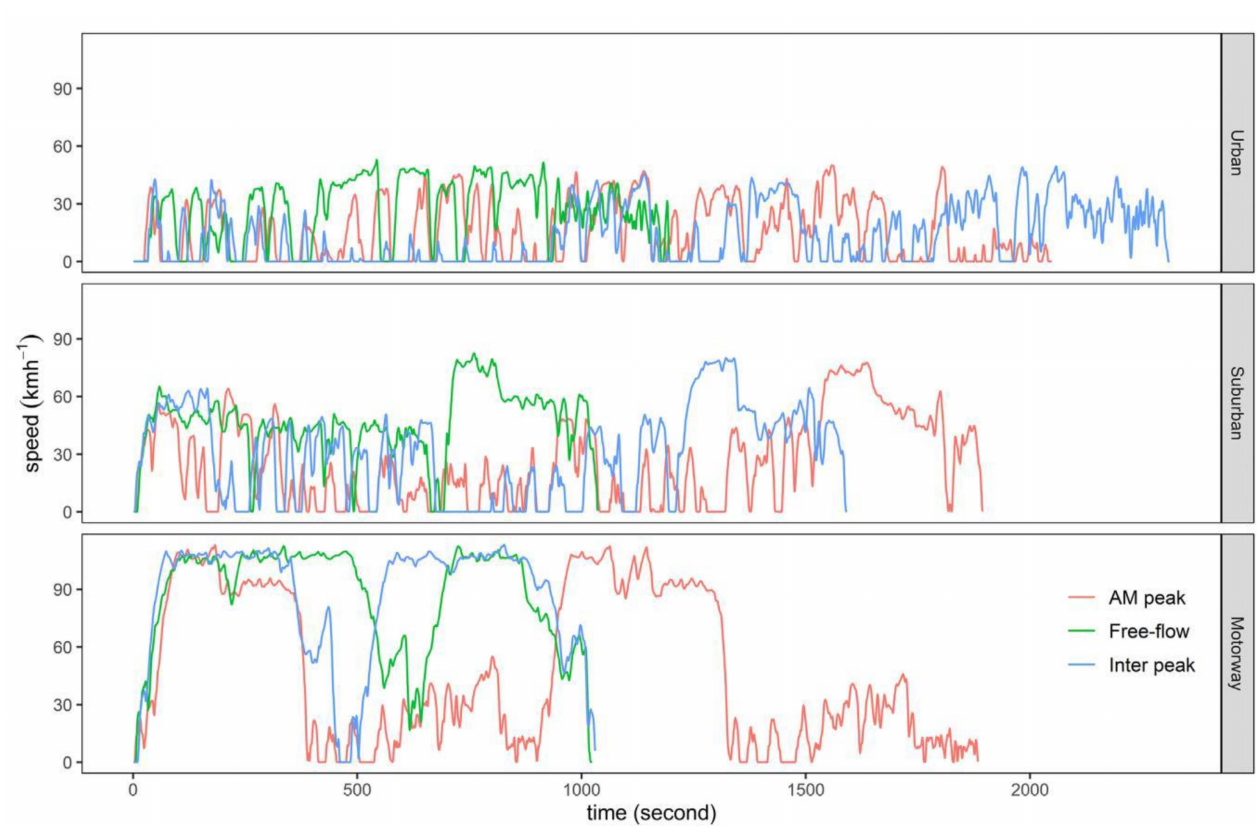
Figure 5. The London Drive Cycle speed profile (three different road types under three different traffic conditions). Adapted from ref. [13], Copyright (2020), with permission from